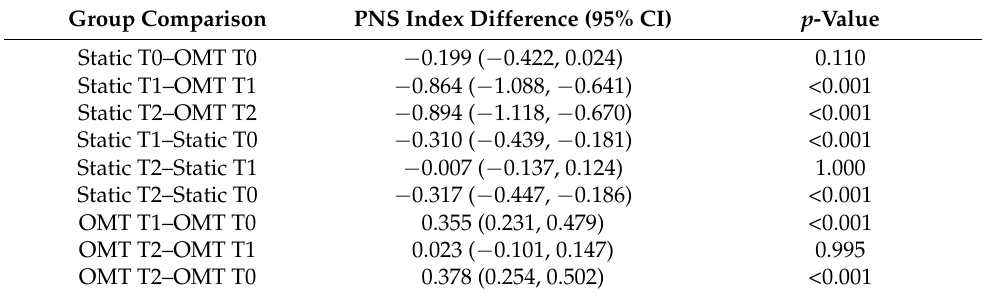
Table 5. Tukey post hoc tests regarding PNS index.